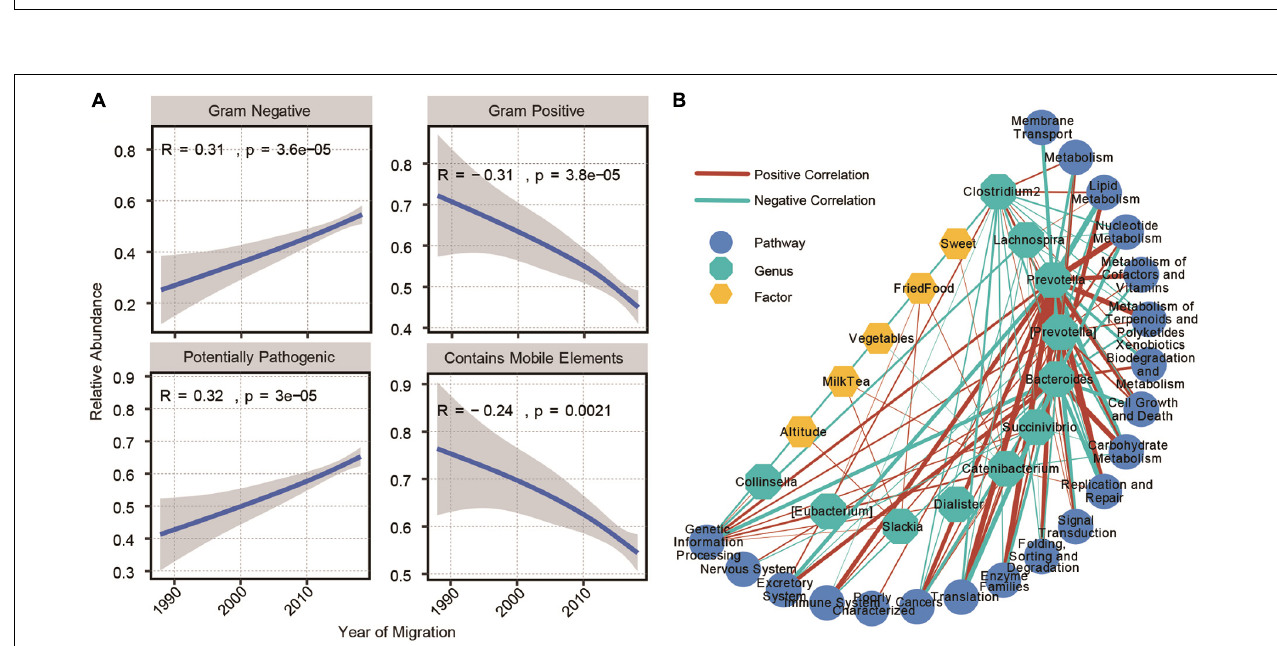
FIGURE 6 | Construction of the network of impact parameters, gut microbiome, and functions. (A) Microbiome phenotypes significantly correlated with the year of emigration from plateau to plain (Spearman’s correlation, adjusted P < 0.05) and immigration generations from plain to plateau (Kendall’s correlation, adjusted P < 0.05). (B) Correlation network between 15 common significantly genera and 20 common predicted KEGG pathways. Their correlations with factors were also displayed (Spearman’s correlation, adjusted P < 0.05, | r | > 0.3).